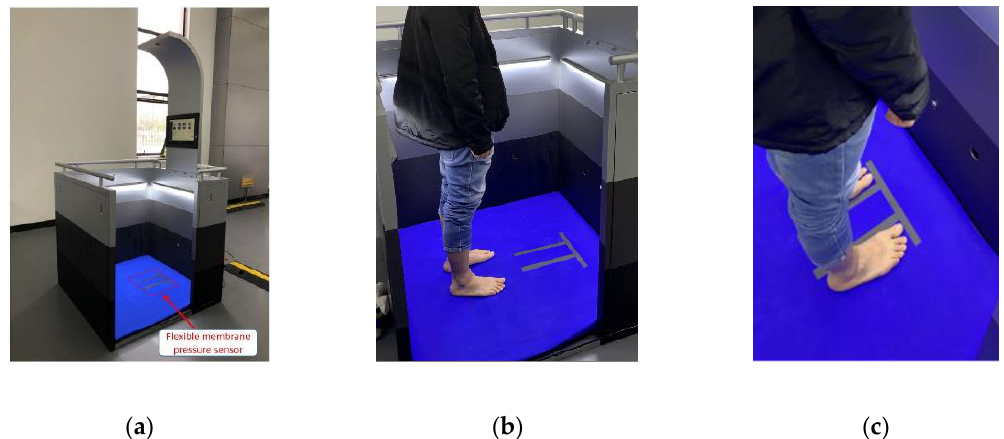
Figure 8. Prototype of foot arch index measurement. ( a ) is the designed prototype, and ( b ) and ( c ) show the correct test position.